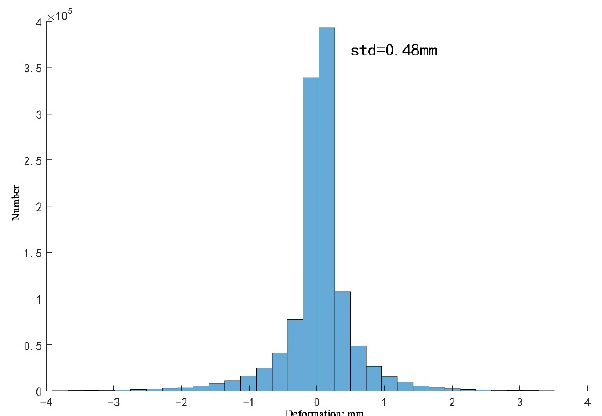
Figure 11. 10/29 20:29 Residual plot of real value and predicted value.